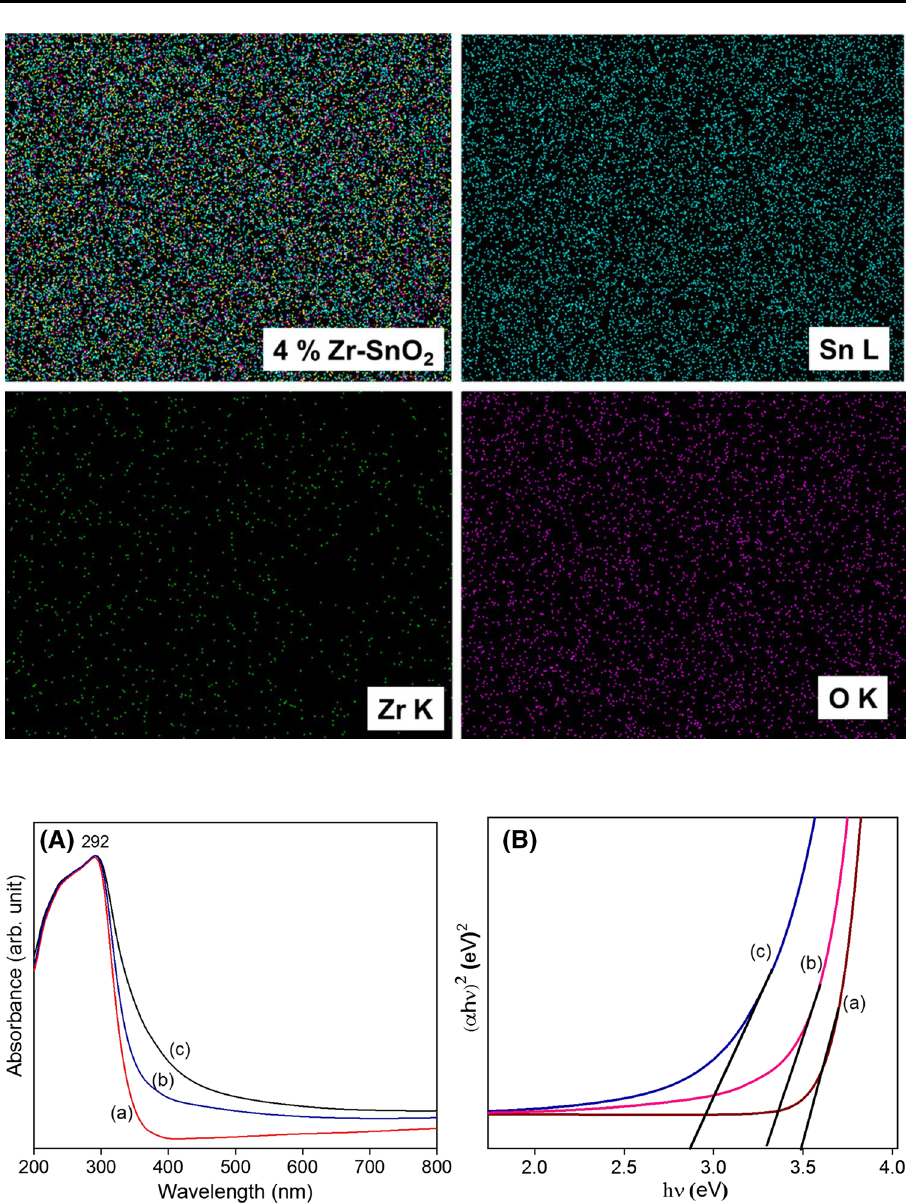
Fig. 4 EDAX elemental map- ping of 4% Zr-doped SnO 2 NPs